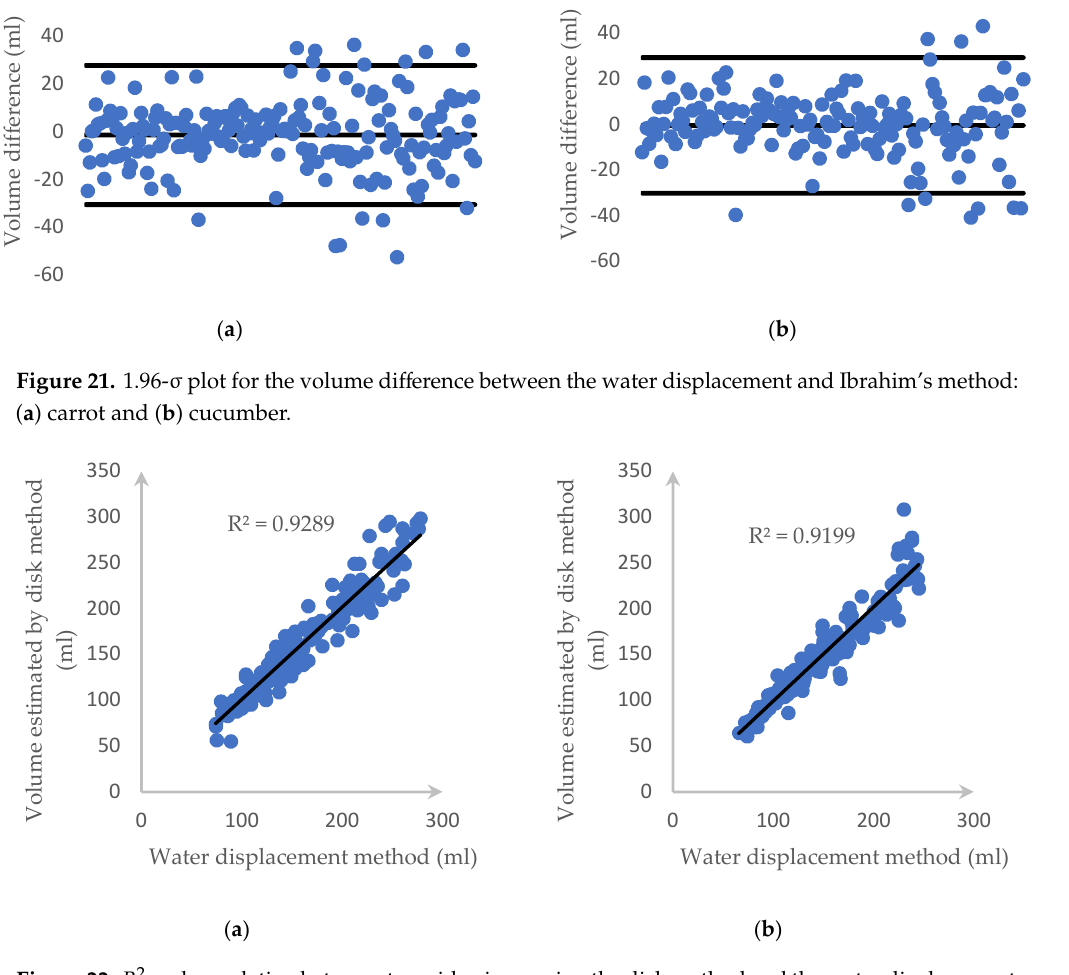
Figure 22. R 2 and correlation between two side views using the disk method and the water displacement method for ( a ) a carrot and ( b ) a cucumber.